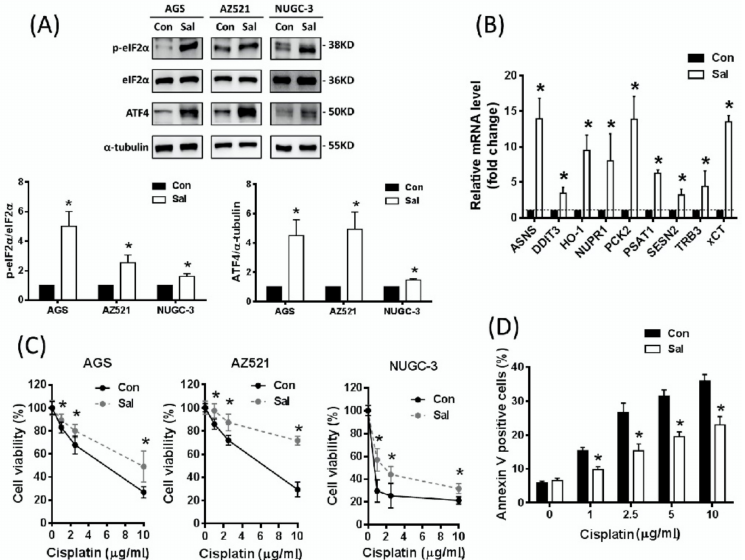
Figure 1. Salubrinal activates integrated stress response (ISR) and induces cisplatin resistance in gastric cancer cells. ( A ) The AGS, AZ521, and NUGC-3 gastric cancer cells were treated with salubrinal (Sal, 30 µ M) for 24 h and the eukaryotic translation initiation factor 2 α (eIF2 α )–activating transcription factor-4 (ATF4) pathway (ISR) was analysed by Western blot analysis. The immunoblot values were normalized to α